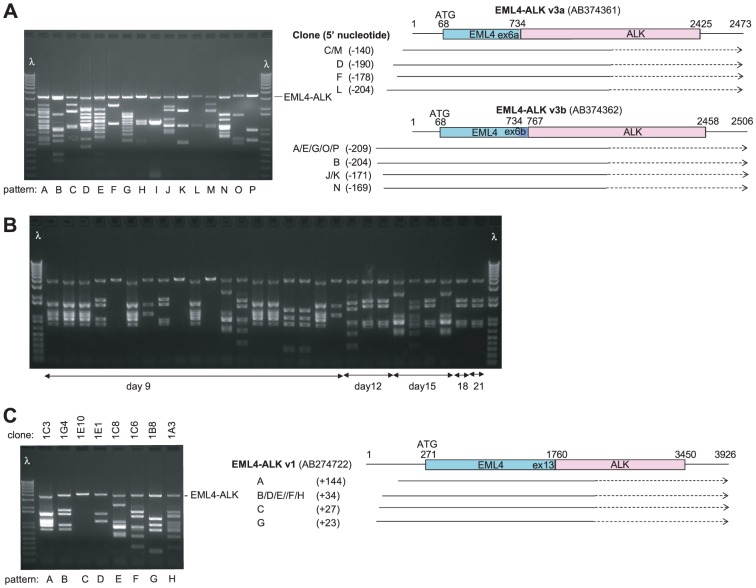
cDNA library screening identifies EML4-ALK.
A. Screening of a library generated from H2228 cells generated 16 clones with distinct patterns of integrated cDNA. All clones contained one of two EML4-ALK transcripts that differed based on splicing of exon 6 and the length of the 5′ untranslated region, as indicated by the most 5′ nucleotide fused to the attB sequence. λ indicates size ladder. B. Screening of a library generated from H3122 cells generated Ba/F3 clones isolated at the indicated time point after withdrawal of IL3. PCR is shown using primers that amplify integrated cDNA. C. PCR amplification from eight clones generated from the H3122 library with different patterns of integrated cDNA. Five distinct EML4-ALK transcripts were identified based on differences in the length of the 5′ untranslated region, as in A.